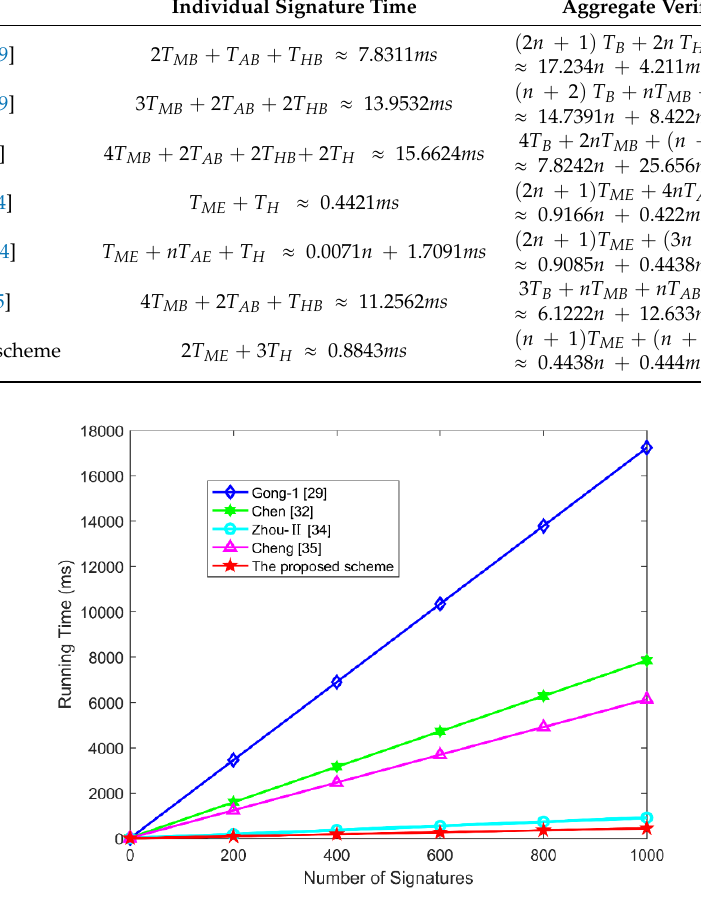
Figure 3. The comparison of aggregate verification time. Table 6. The comparison of communication cost.